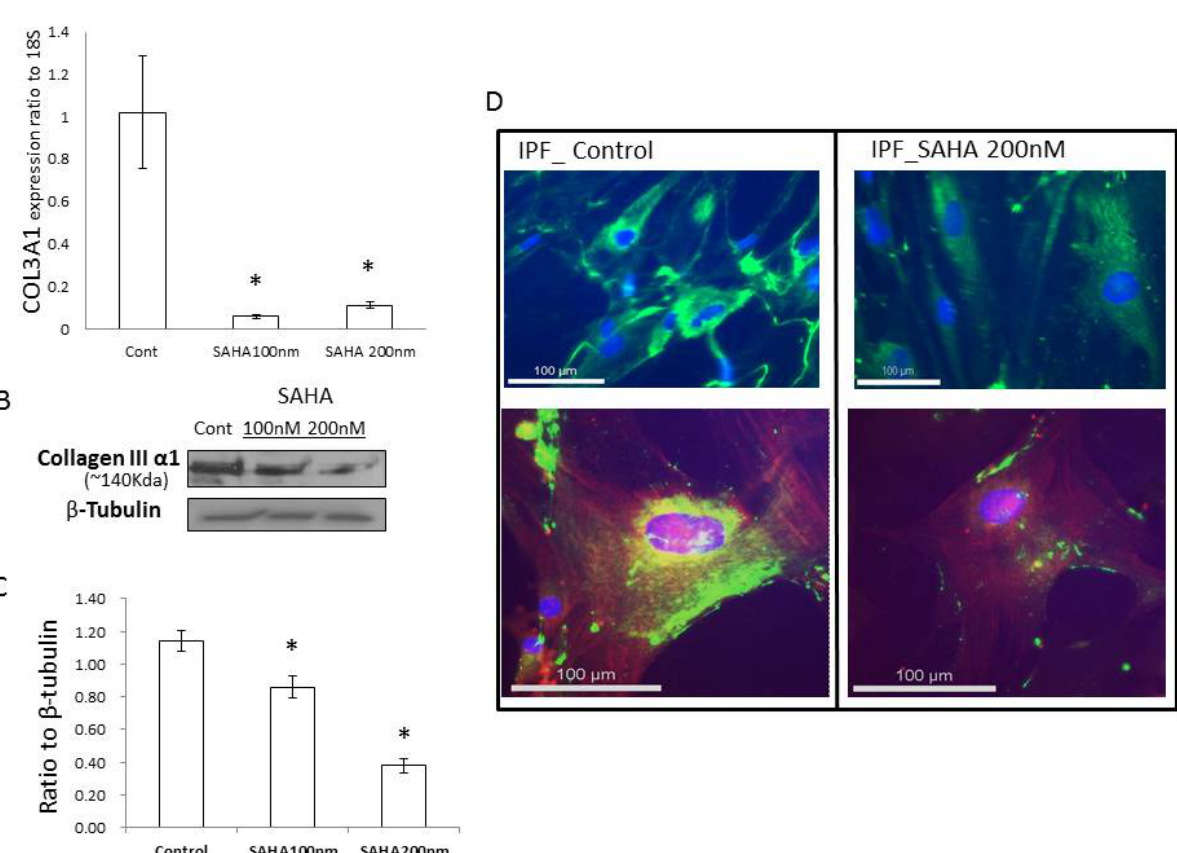
Figure 2. COL3A1 expression in IPF primary fibroblasts with or without suberoylanilide hydroxamic acid (SAHA) treatment. ( A ) Expression of mRNA COL3A1 in IPF cells with or without SAHA by real-time RT-PCR; ( B and C ) Expression of collagen III in IPF whole cell lysate, which indicates intracellular collagen III, by Western blot with 8% SDS-PAGE gel under reducing condition (more information is available in the online supplementary data). Collagen III α 1 is at approximately 140 kDa marker [15]. β -tubulin was used as a loading control; C is densitometry by blots like B ; ( D ) Representative pictures of immunofluorescence of IPF cells without (left) and with (right) SAHA, stained with α -SMA (red, bottom) and collagen III (green). Top panels: IPF fibroblasts stained with Col3A1 anti-body (green) indicating intracellular collagen III; nuclei are stained blue (DAPI). Bottom panel: IPF fibroblasts stained with Col3A1 (green) and α -SMA (red); nuclei stained blue (DAPI). The scale bar as shown at the left bottom corner is for 100 µm. The results are the average of at least three independent experiments. The bars indicate the mean ± SD. * p < 0.05 compared to the